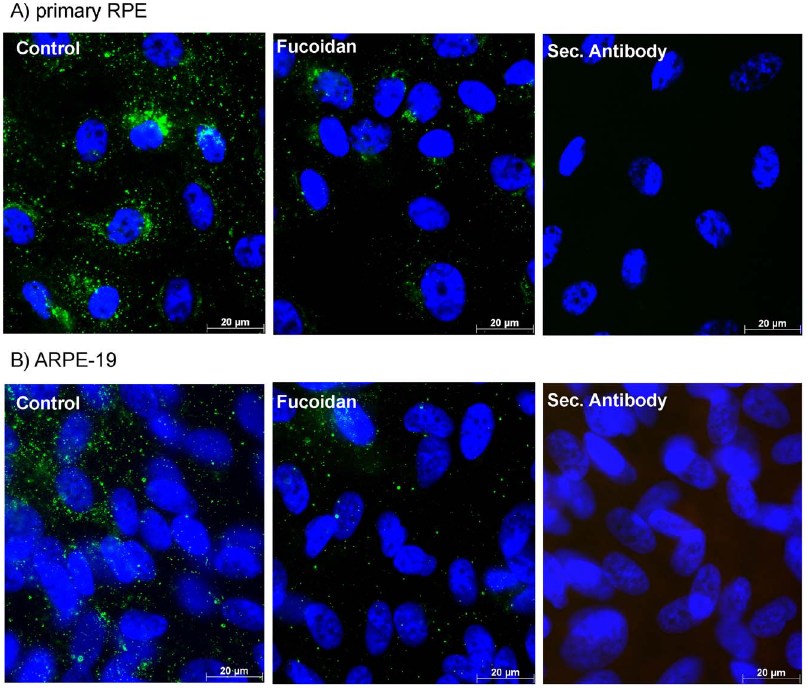
Figure 5. VEGF165 expression. Primary RPE cells (A) and ARPE-19 cells (B) were treated with 100 m g/ml fucoidan for 24 hours and the expression of intracellular VEGF (still containing signal peptide) was evaluated using immunocytochemistry. Cells treated with fucoidan exhibited a substantial decrease in intracellular VEGF expression.